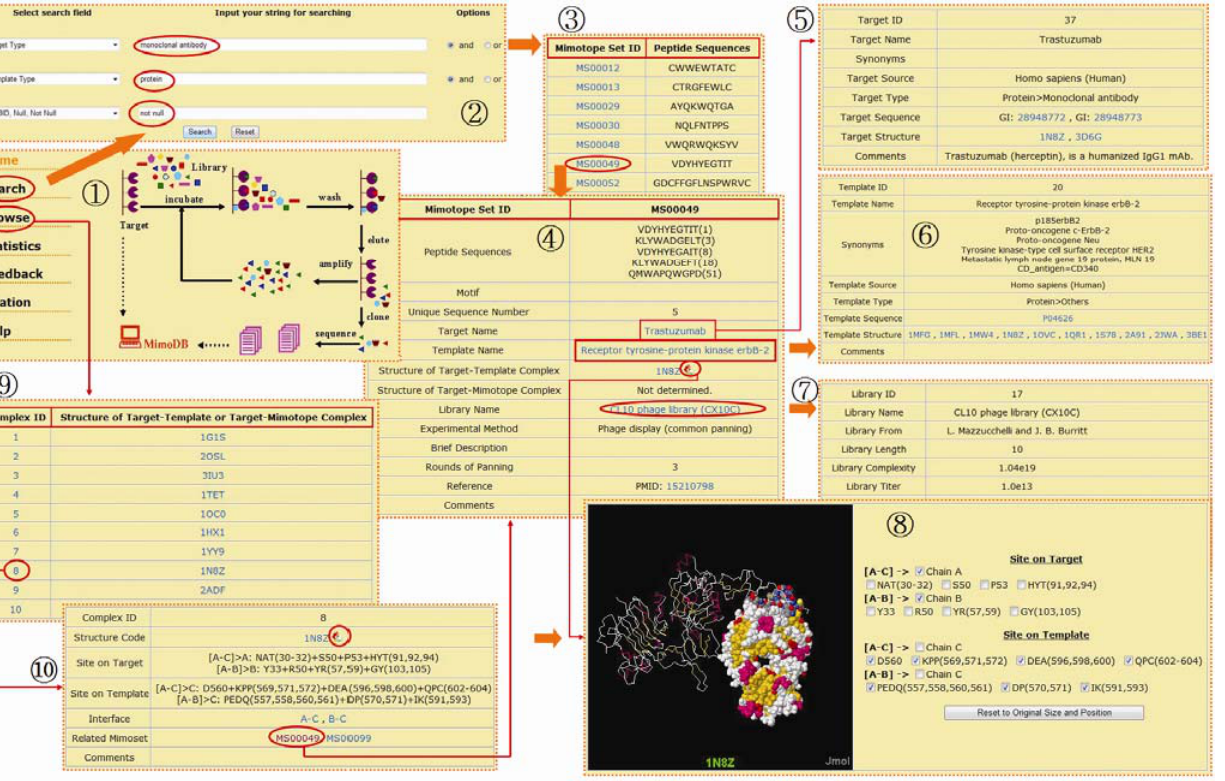
Figure 1. A series of screenshots showing navigation in the MimoDB database. (1) Homepage of MimoDB. (2) Search interface. (3) Search results. (4) Browse an entry of mimotope set. (5) Browse the related target. (6) Browse the related template. (7) Browse the related library. (8) View the interaction sites between target and template interactively. (9) Summary table of complex structure. (10) Browse an entry of target-template complex